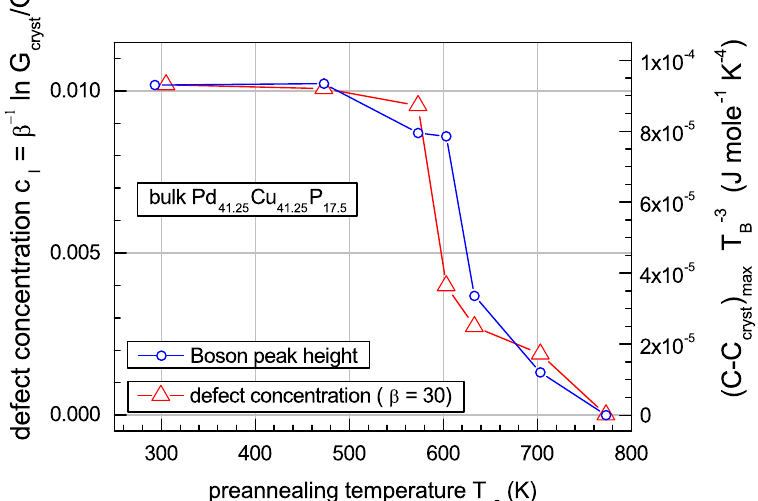
Cu P calculated 41 : 25 41 : 25 17 : 5 . The curves are drawn as guides for the eye. It is a can a